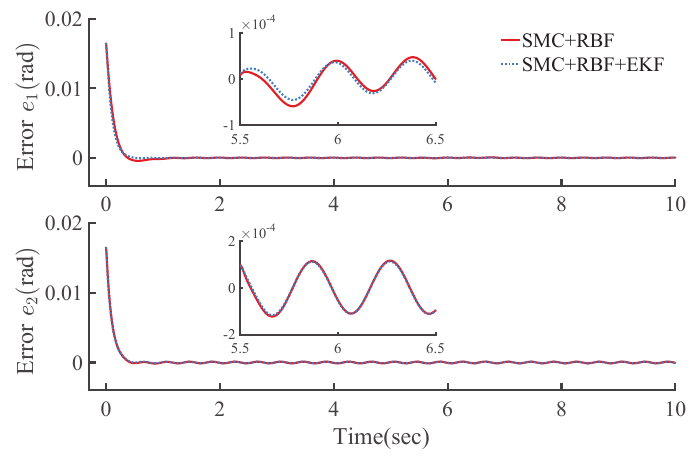
Figure 10. Trajectory tracking error e